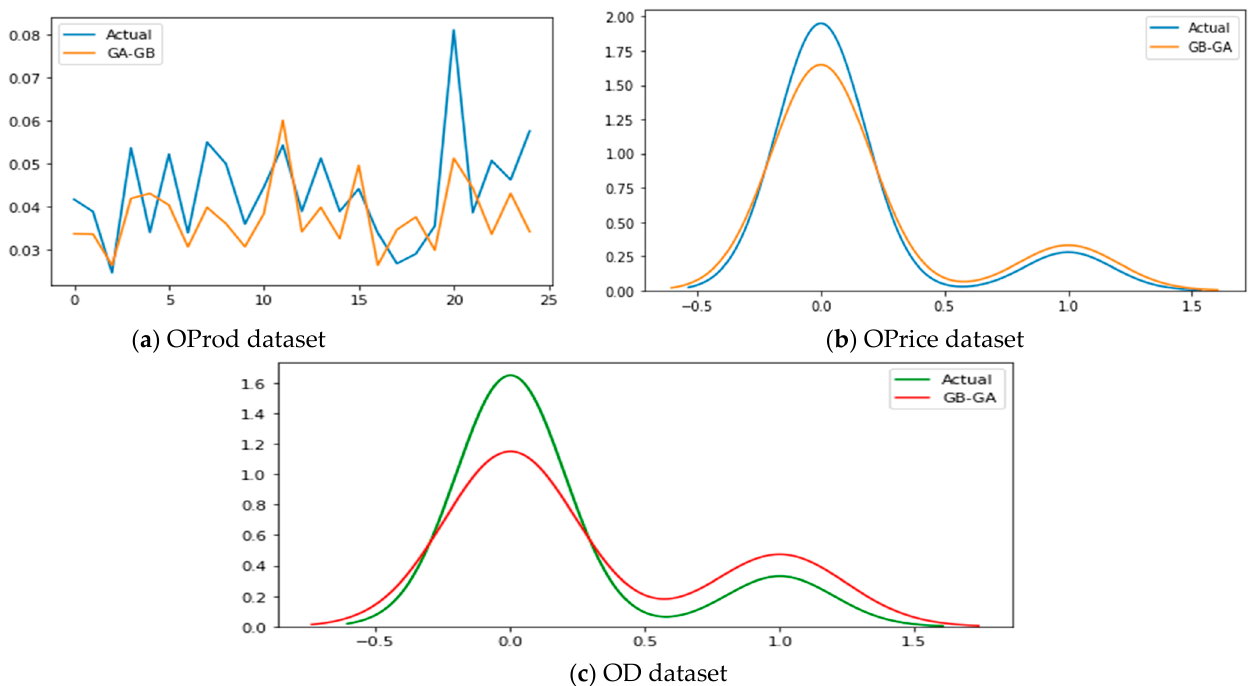
Figure 4. Comparison between the models used in the term of coefficient of determination (R 2 ) using OD